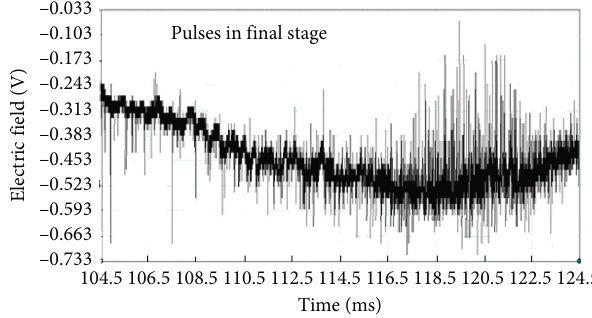
Figure 6: Expansion of the final stage of flash containing fine pulses with both polarities.